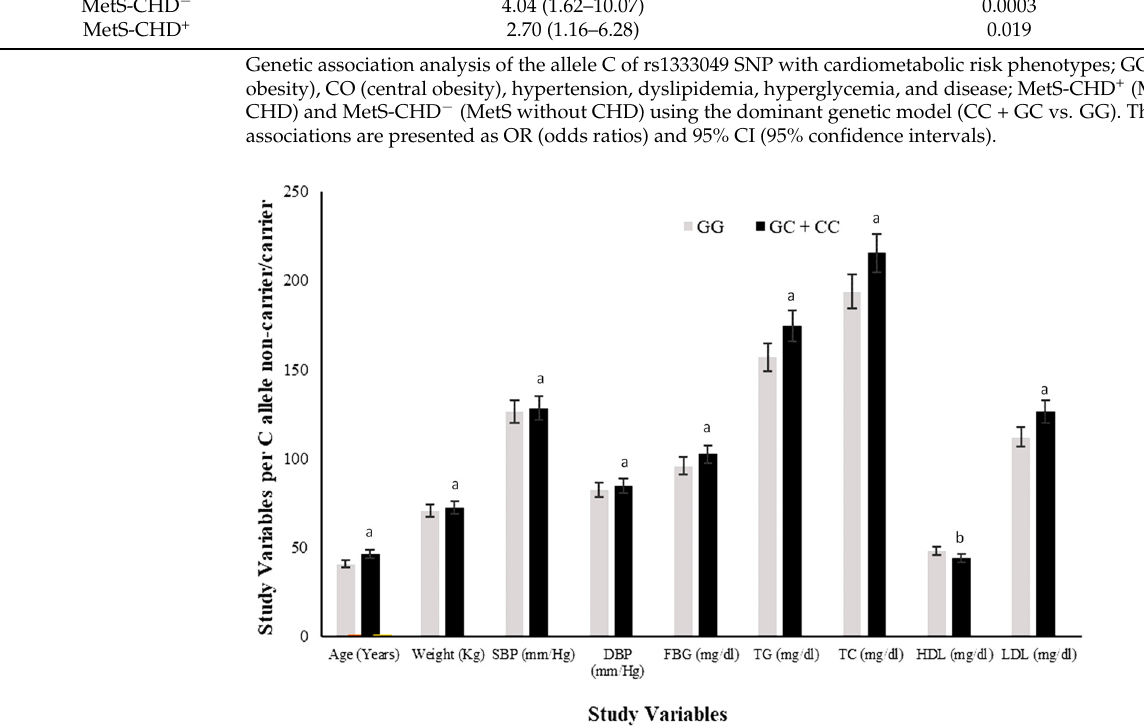
Figure 3. Comparison of study variables in rs1333049 SNP minor/risk (C) allele and major (G) allele carriers. Comparison of the levels of all study variables among G allele carrier (GG homozygotes) and C allele carrier (GC heterozygotes and CC homozygotes combined) study subjects. The levels of all study variables were raised in C allele carriers while HDL was lower compared with that of G allele carriers. The superscript “a” on bars for variables shows significantly higher levels in C allele carriers versus G allele carriers. Whereas superscript “b” on bars shows significantly lower levels in C allele carriers vs. G allele carriers.